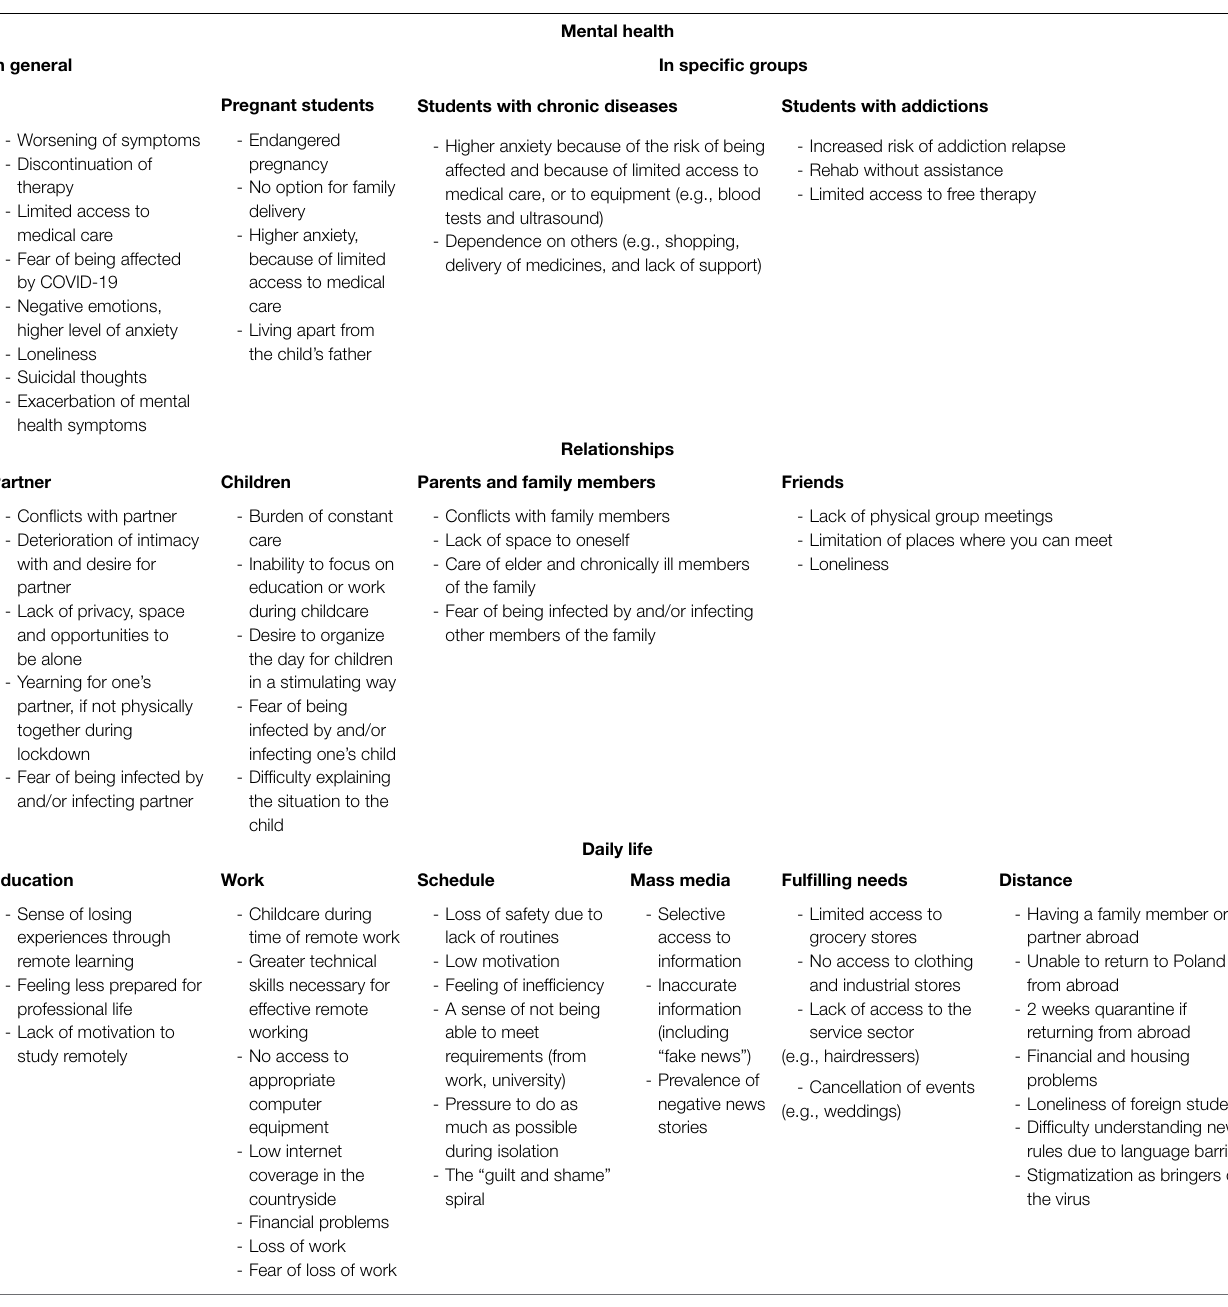
TABLE 1 | Challenges reported by supported